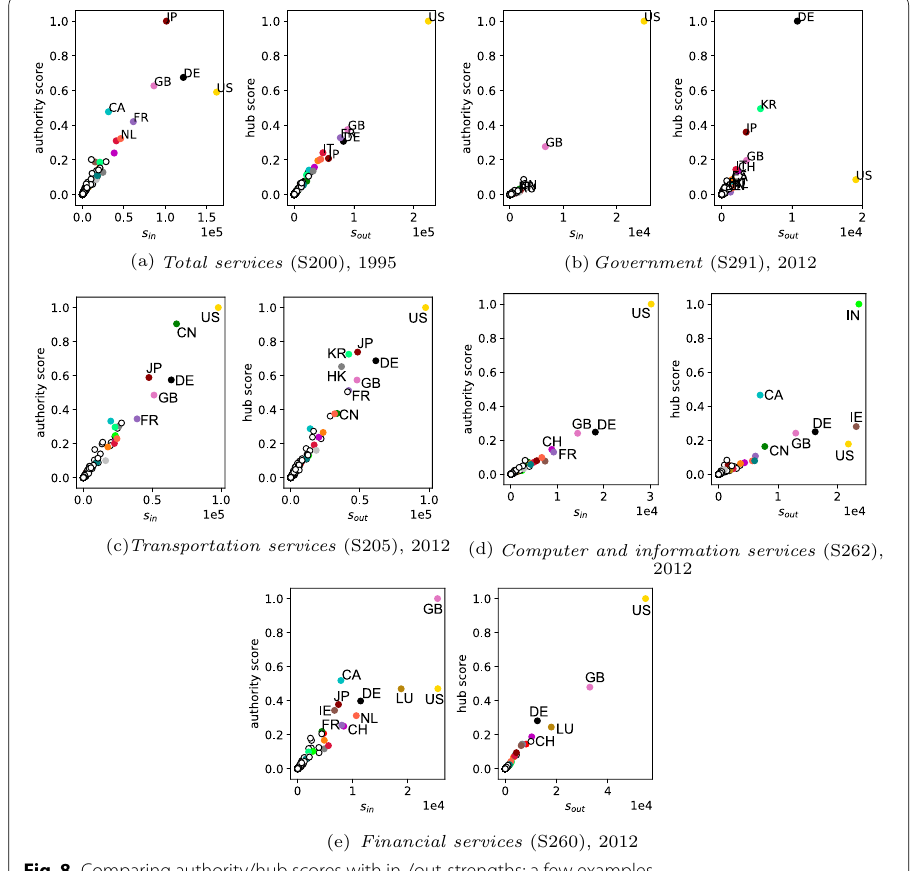
Fig. 8 Comparing authority/hub scores with in-/out-strengths: a few